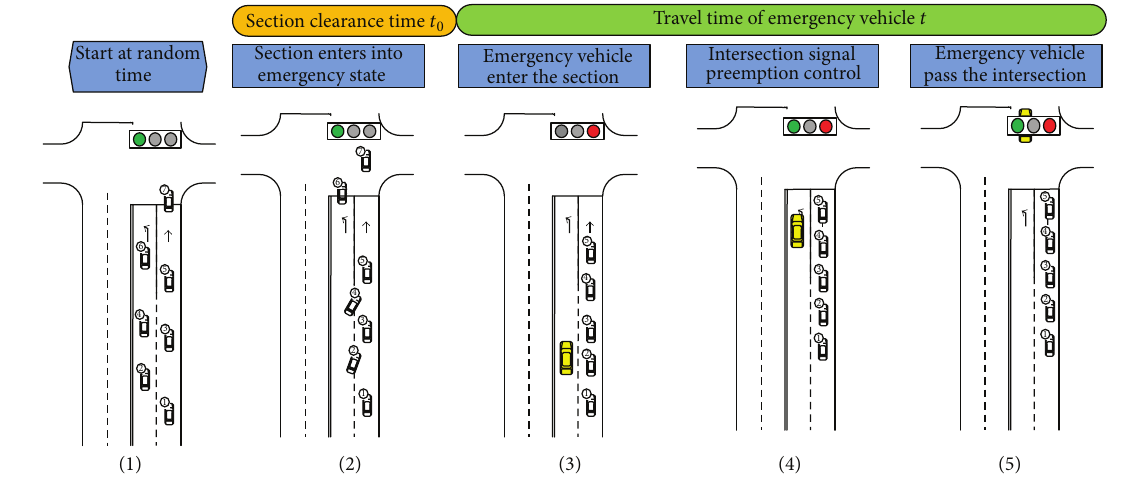
Figure 5: Main processes of simulation based on VISSIM. Table 4: Parameters of control strategy in evaluation.